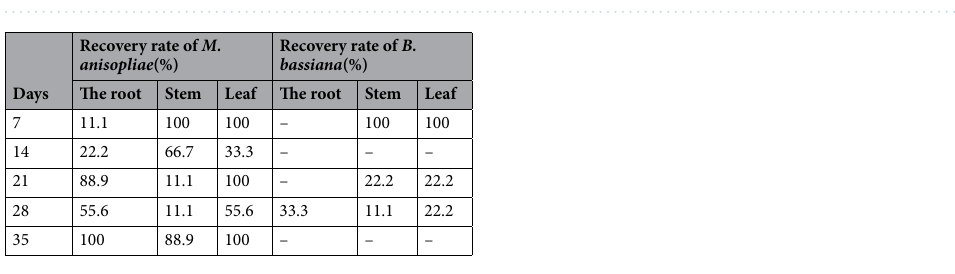
Recovery rate of M. anisopliae (%) Days